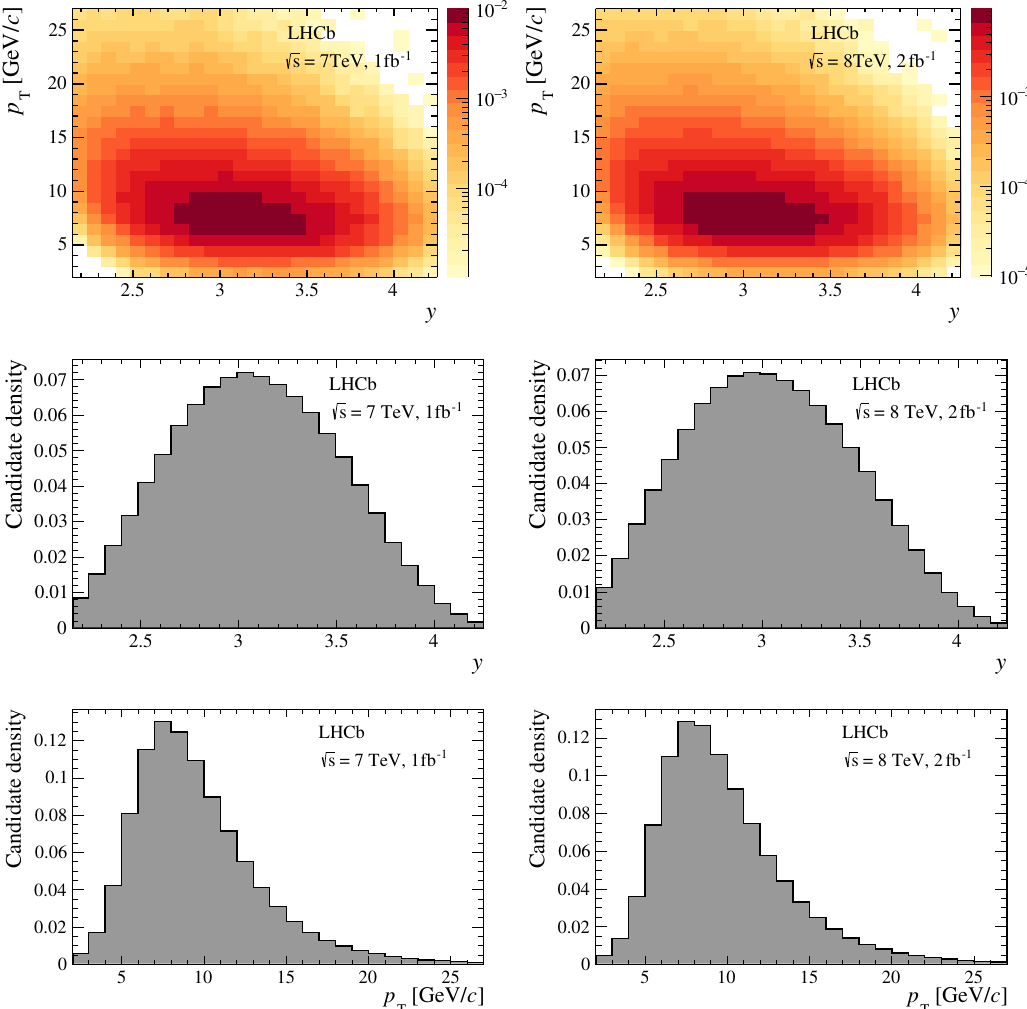
Figure 13 . Measured, normalised distributions of p T ; y from background-subtracted (cid:3) 0 for (left) p s = 7 TeV and (right) p s = 8 TeV data. The distributions are not corrected for the detector efficiency. Darker areas correspond to more densely populated regions. Below the two- dimensional histogram, the projections in y and p T are